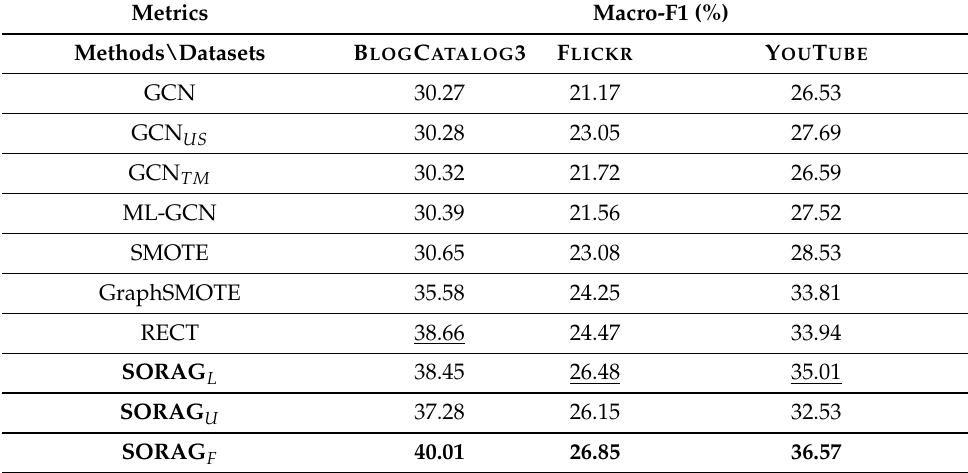
Table 3. Imbalanced multi-label classification comparison in terms of Macro-F1. The first and second best results are boldfaced and underscored,